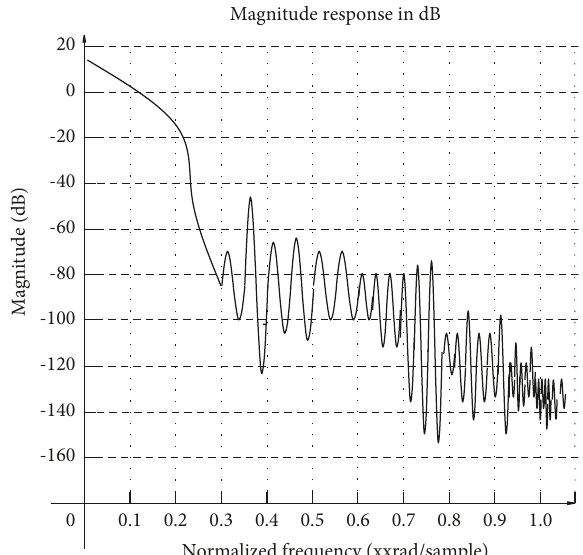
Figure 10: Frequency response of FIR low-pass filter with a normalized cutoff frequency 0 . 2 π